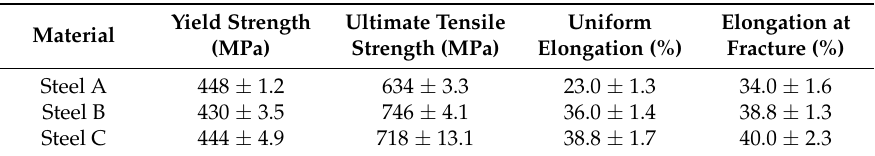
Table 2. Volume fraction of ferromagnetic phases in the test materials.